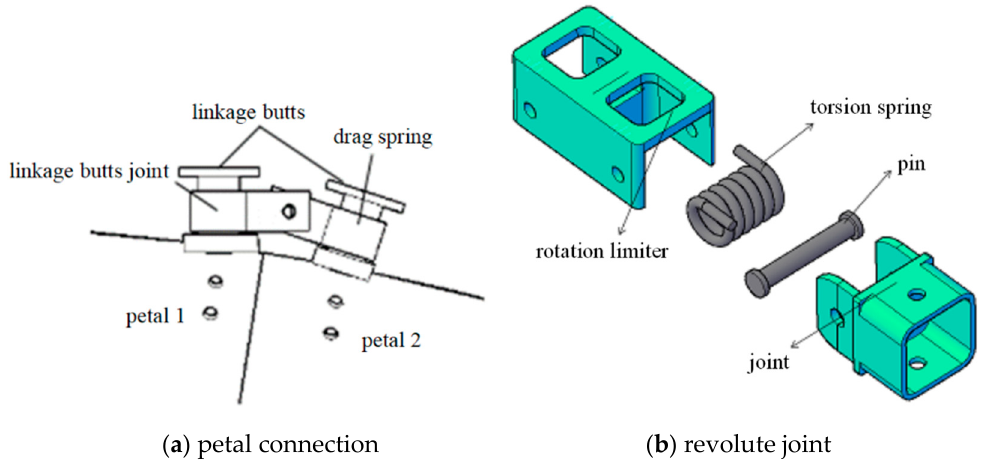
Figure 2. Schematic diagram of model details.